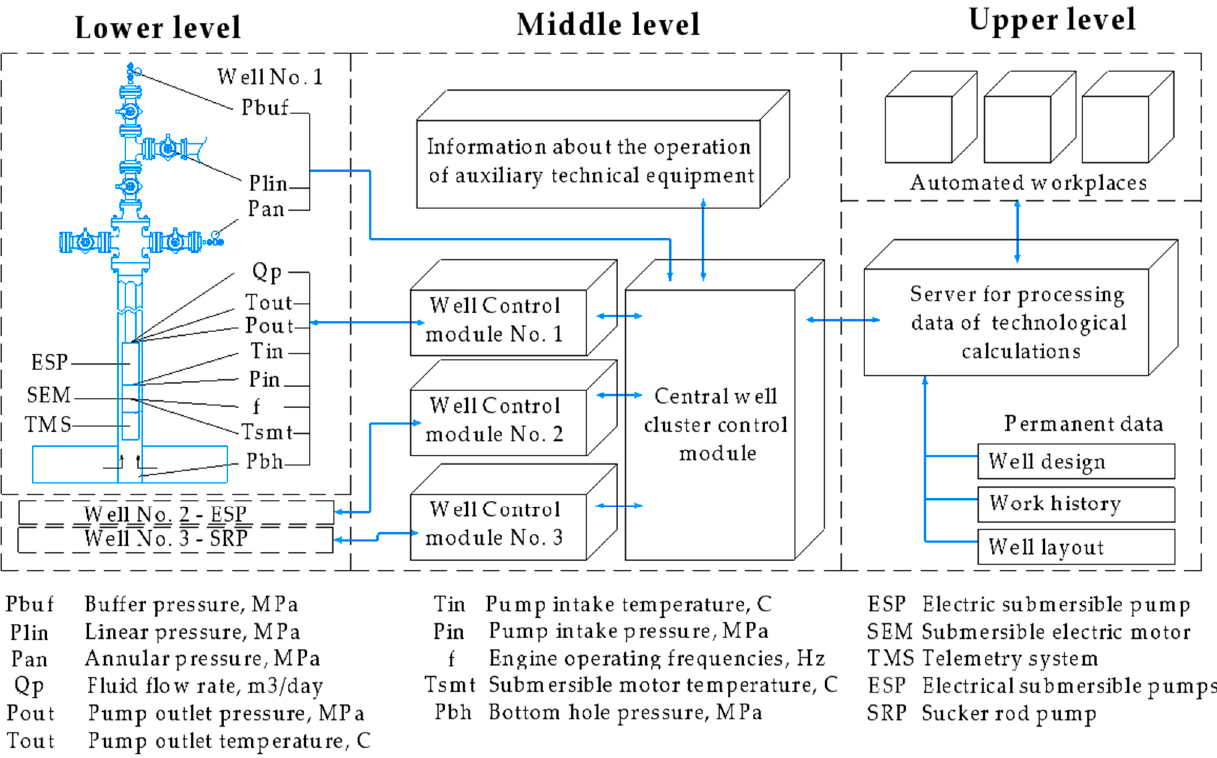
Figure 2. Automated well cluster control system.